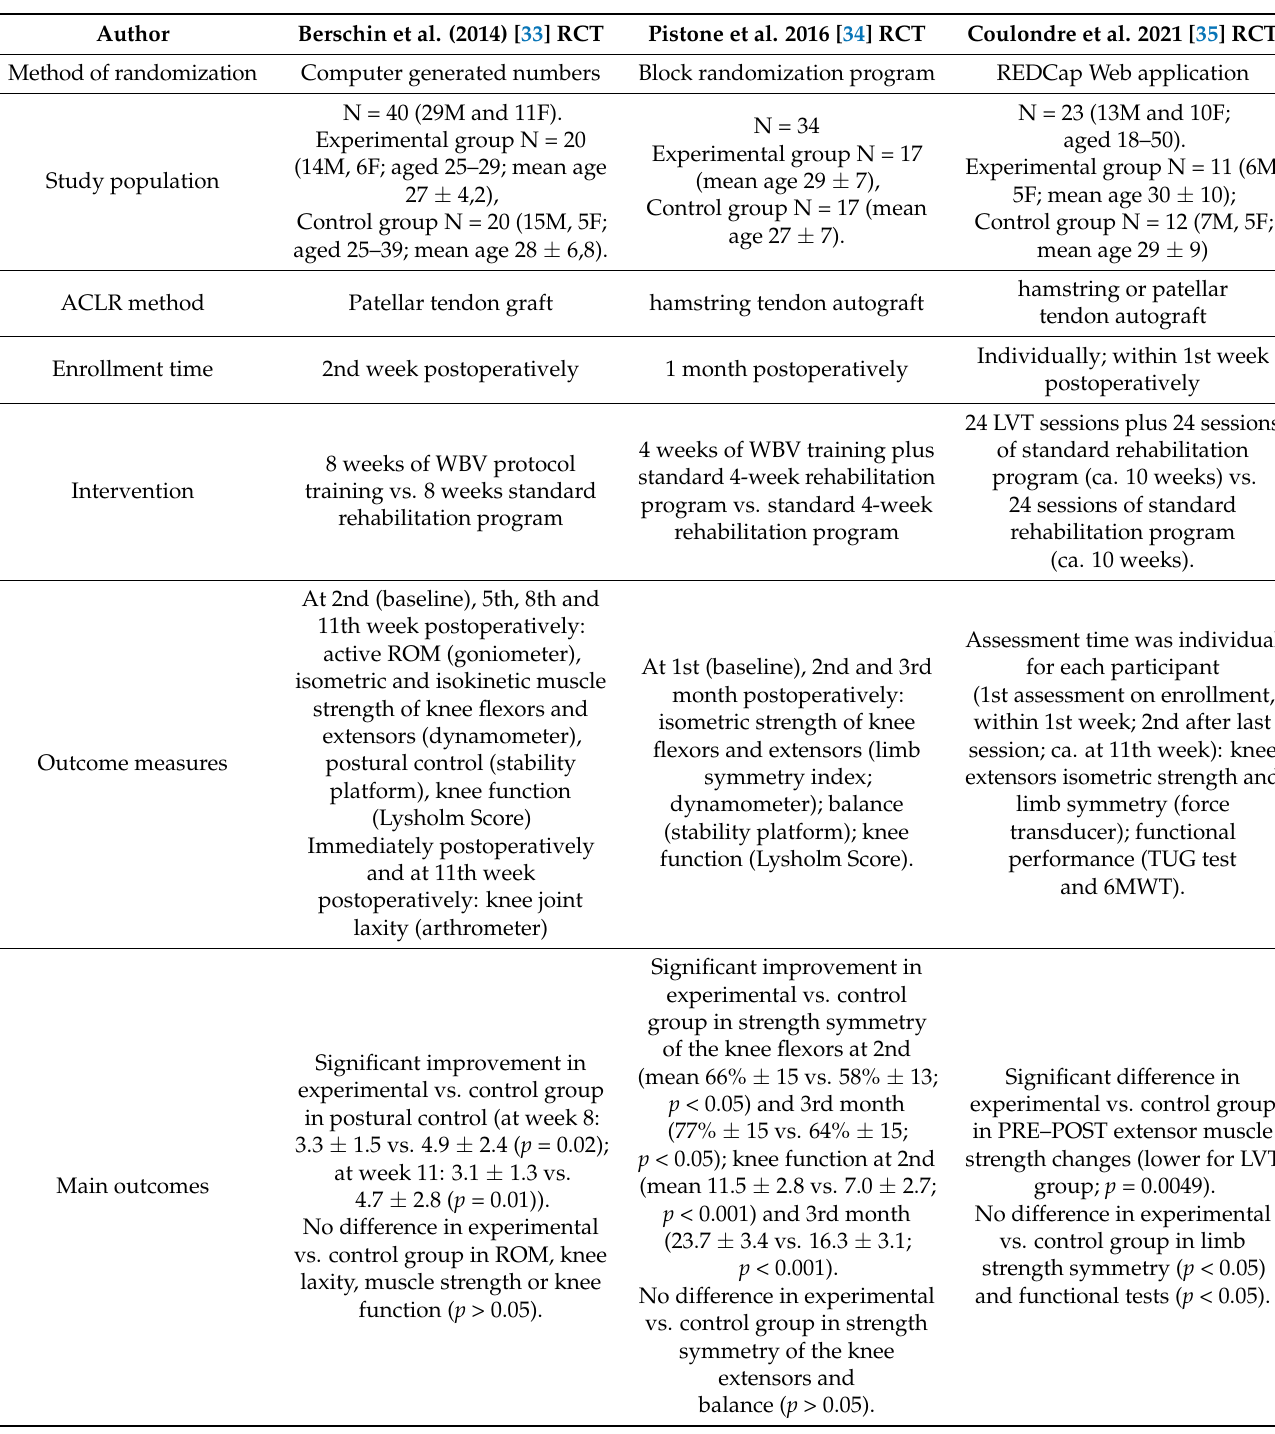
Table 8. Summary of reviewed studies on WBV and